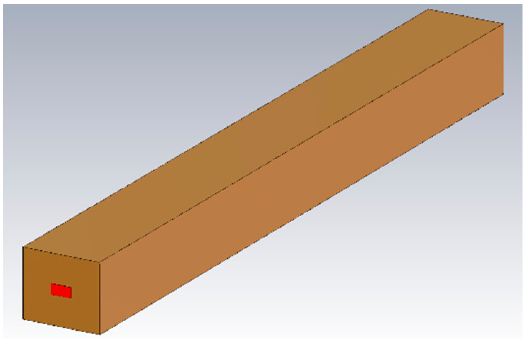
Figure 14. The model of the WR2.8 waveguide used in the CST calculation. The copper conductivity was set as 2.95 × 10 7 S/m in calculation.